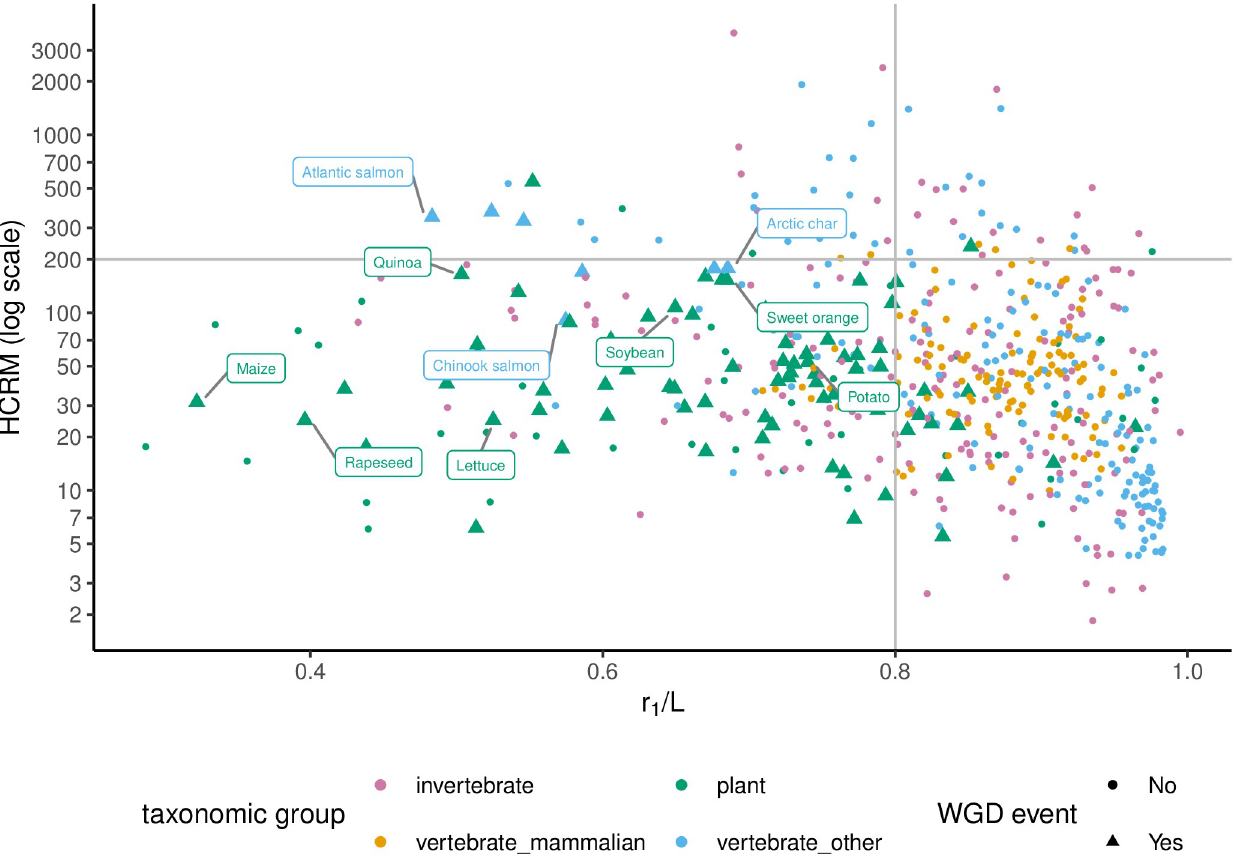
Fig 5. High copy repeats per million versus uniqueness ratio among genomes with and without known recent WGD events. Most of genomes with known recent WGD events had r 1 / L < 0.8 and HCRM < 200. The y-axis is in a logarithmic scale. HCRM values are computed from genome-skims simulated at 1X coverage with no sequencing error. Some of the species with a recent WGD are labeled by their common names.